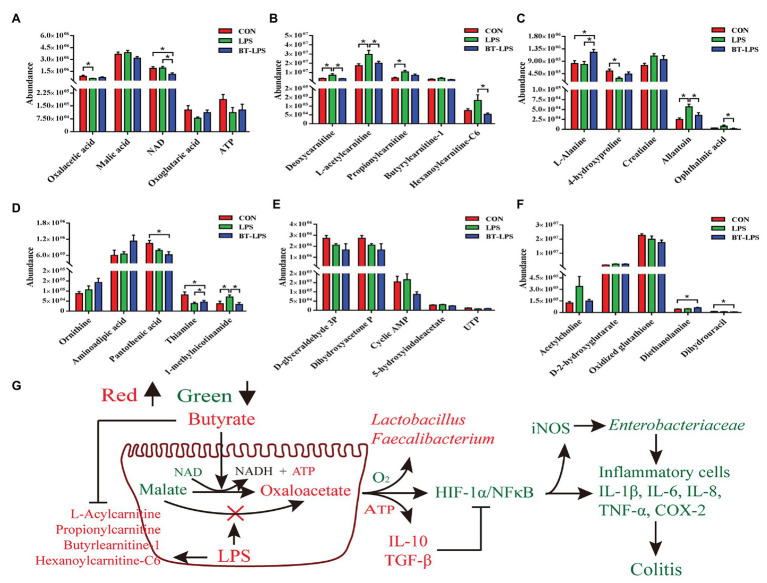
Hydrophilic metabolites in the colon were altered by butyrate supplementation. (A–F) Colonic hydrophilic metabolites with significant difference (p < 0.05) and with difference for tendency (0.05 < p < 0.1) between groups. (G) The integrated immune indexes, 16S rRNA gene sequencing, and targeted metabolome revealed that butyrate supplementation mitigates weanling piglets from LPS-induced colitis via regulating microbiota and energy metabolism of the colon. The red and green colors represent increased and decreased immune parameters for microbes and metabolites, respectively, in the BT-LPS group compared with those in the LPS or CON groups. All values are expressed as the mean ± SEM (n = 6). *p < 0.05.